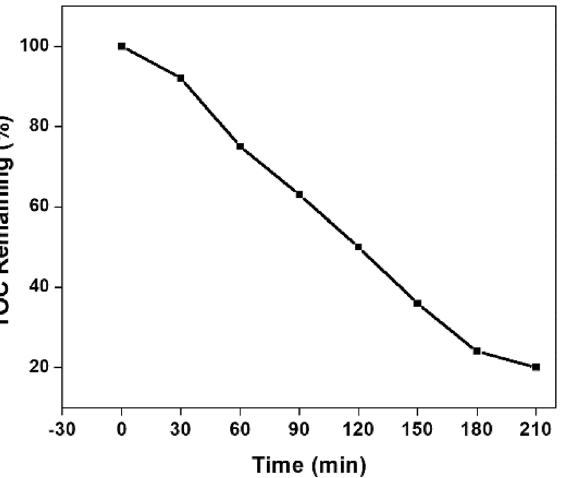
Figure 16. TOC removal efficiency of NT1 (initial concentration = 20 µM, Catalyst dosage = 0.5 g l −1 , pH = 4).